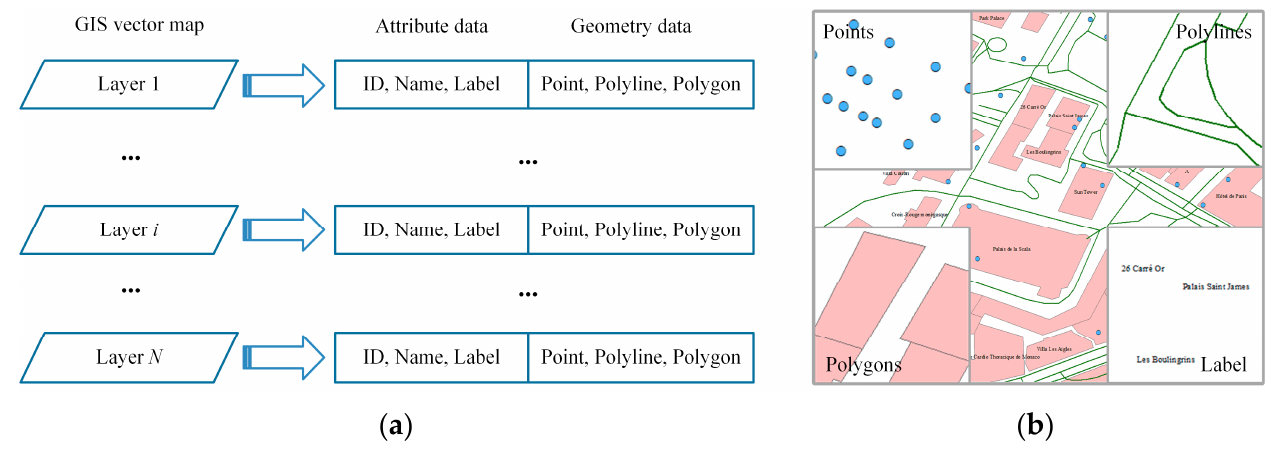
Figure 1. The model and components of the GIS vector map. ( a ) Model of the GIS vector map, ( b ) data components of the GIS vector map.